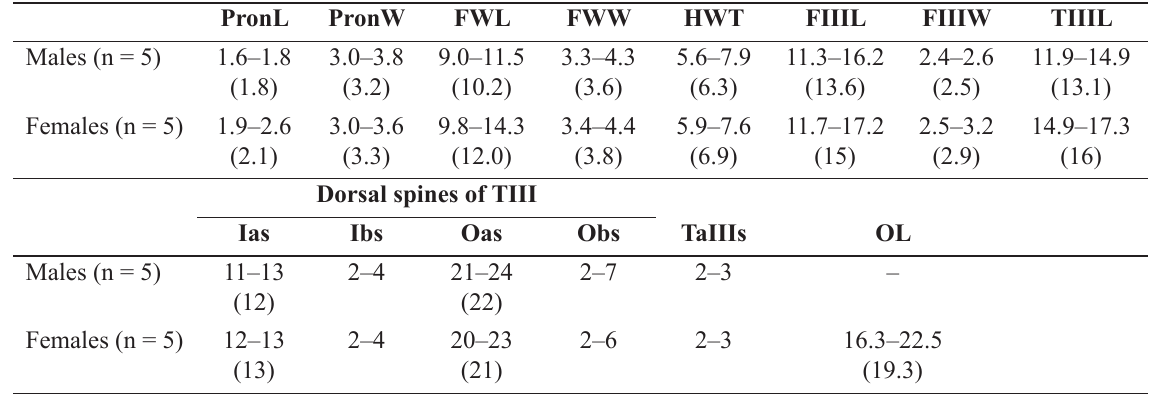
Table 9. Measurements of Nisitrus musicus Ingrisch, 1987 (in mm, means in